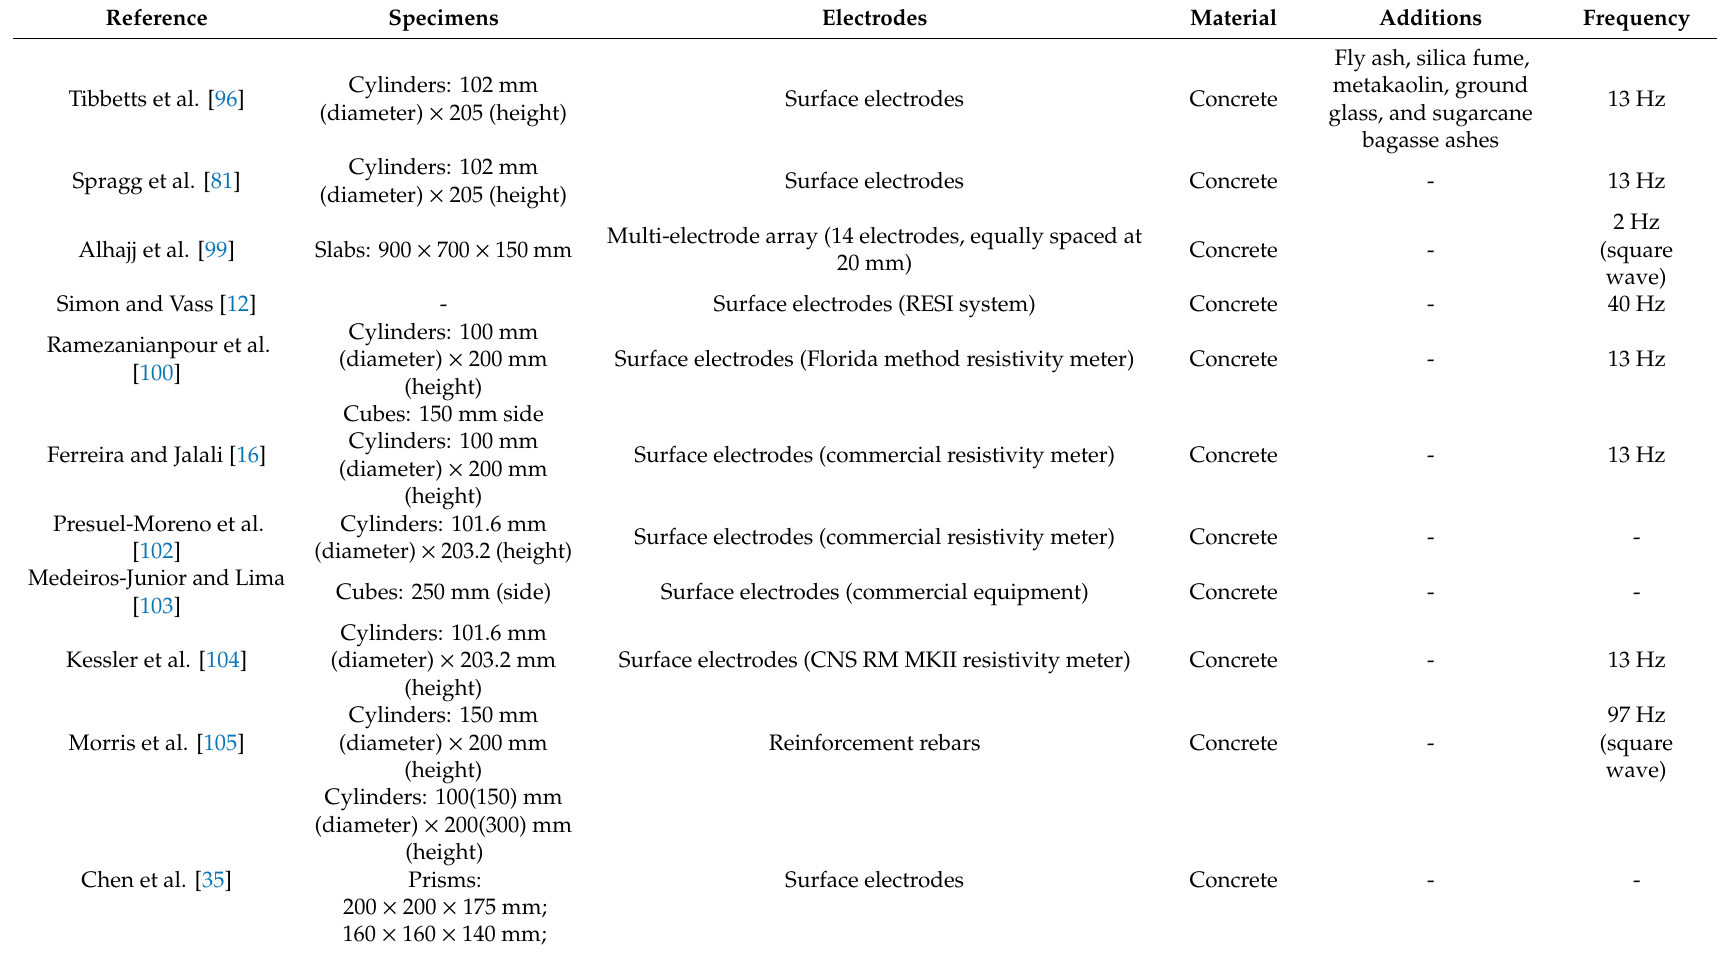
Table 4. AC measurements with 4-point probe